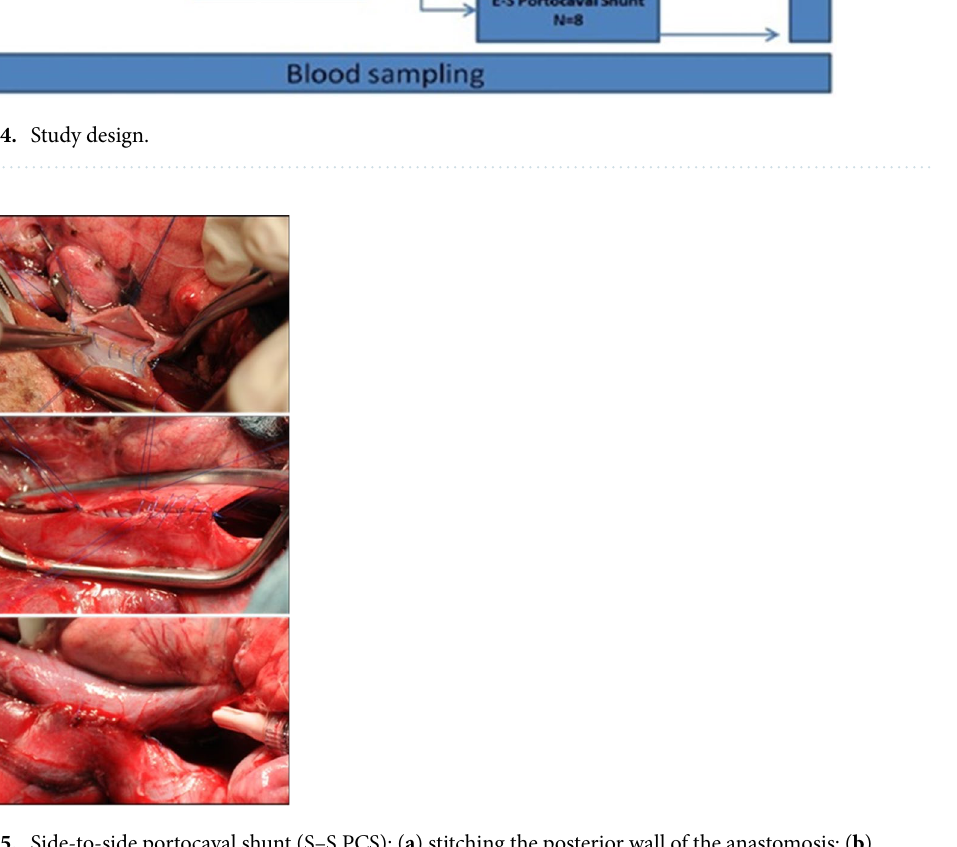
Figure 5. Side-to-side portocaval shunt (S–S PCS): ( a ) stitching the posterior wall of the anastomosis; ( b ) stitching the anterior wall of the anastomosis; ( c ) the complete